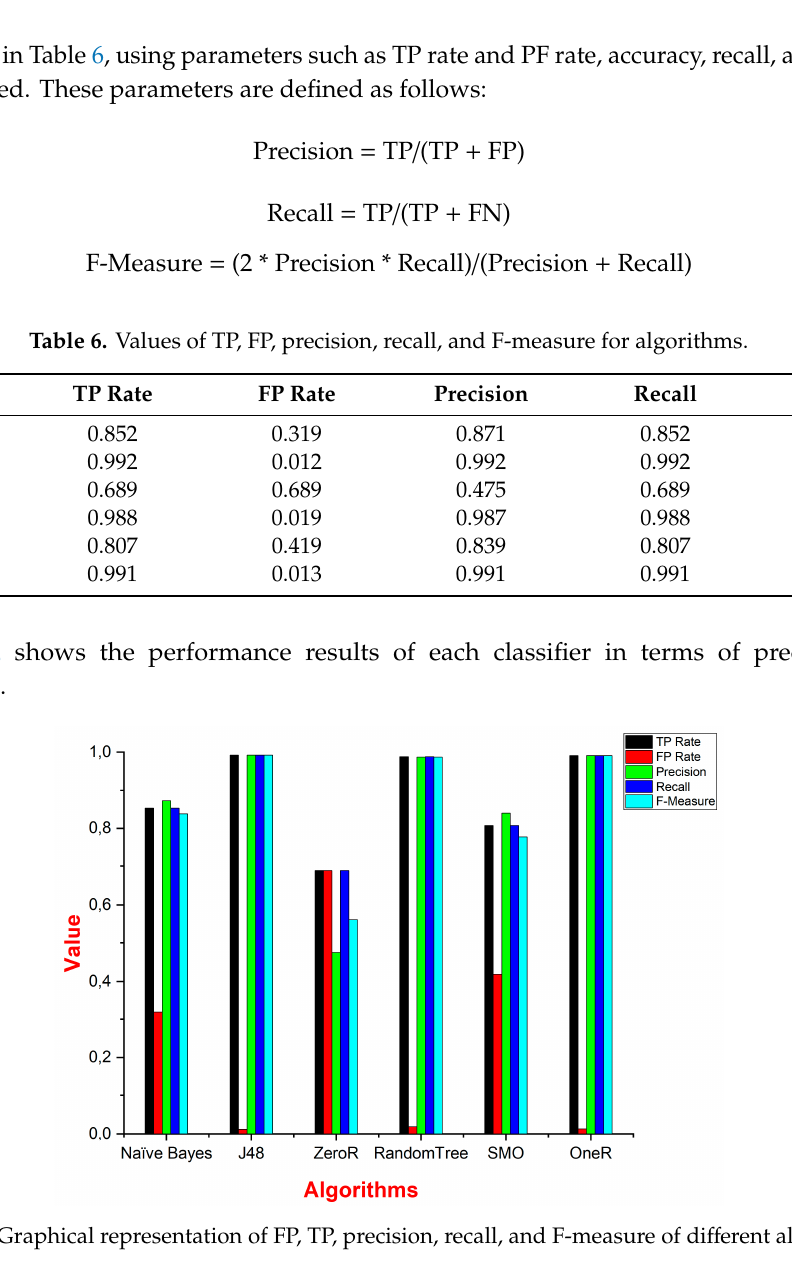
Table 7. Comparison of sensitivity, precision, accuracy, and specificity.